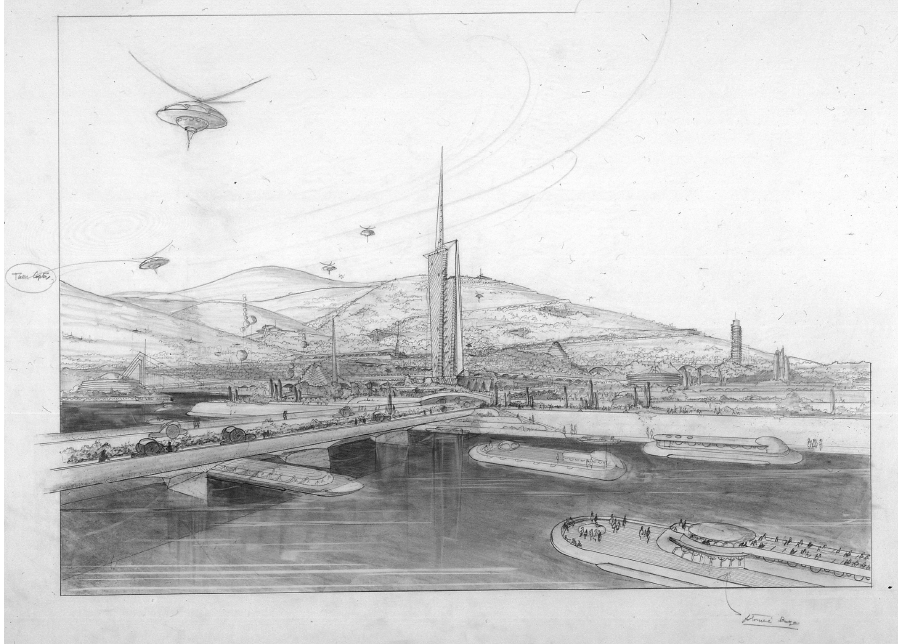
Figure 2. A drawing of the “Broadacre City” as envisioned by Frank Lloyd Wright.